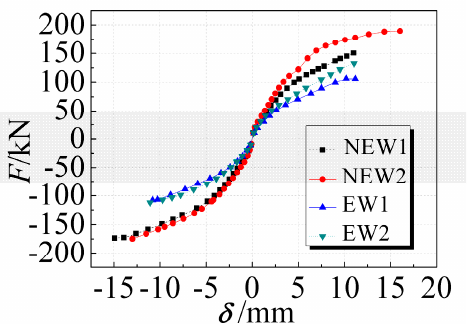
Figure 9. Skeleton curves of specimens.